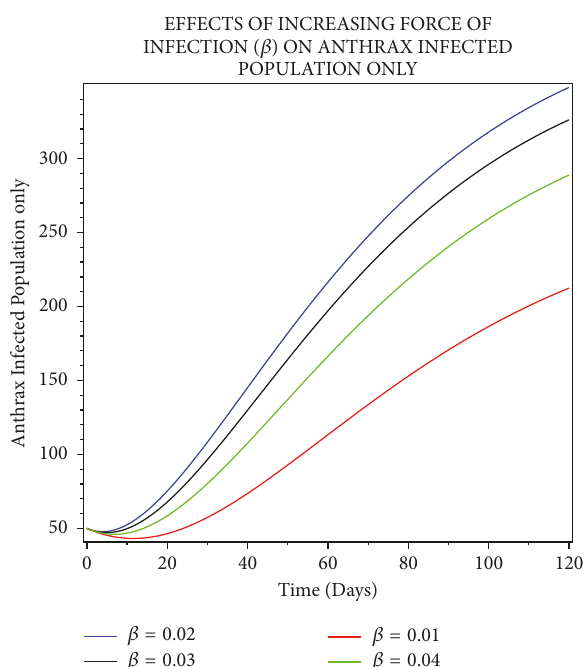
Figure 3: Simulation showing the effects of increasing the force of infection on Anthrax infected population only.